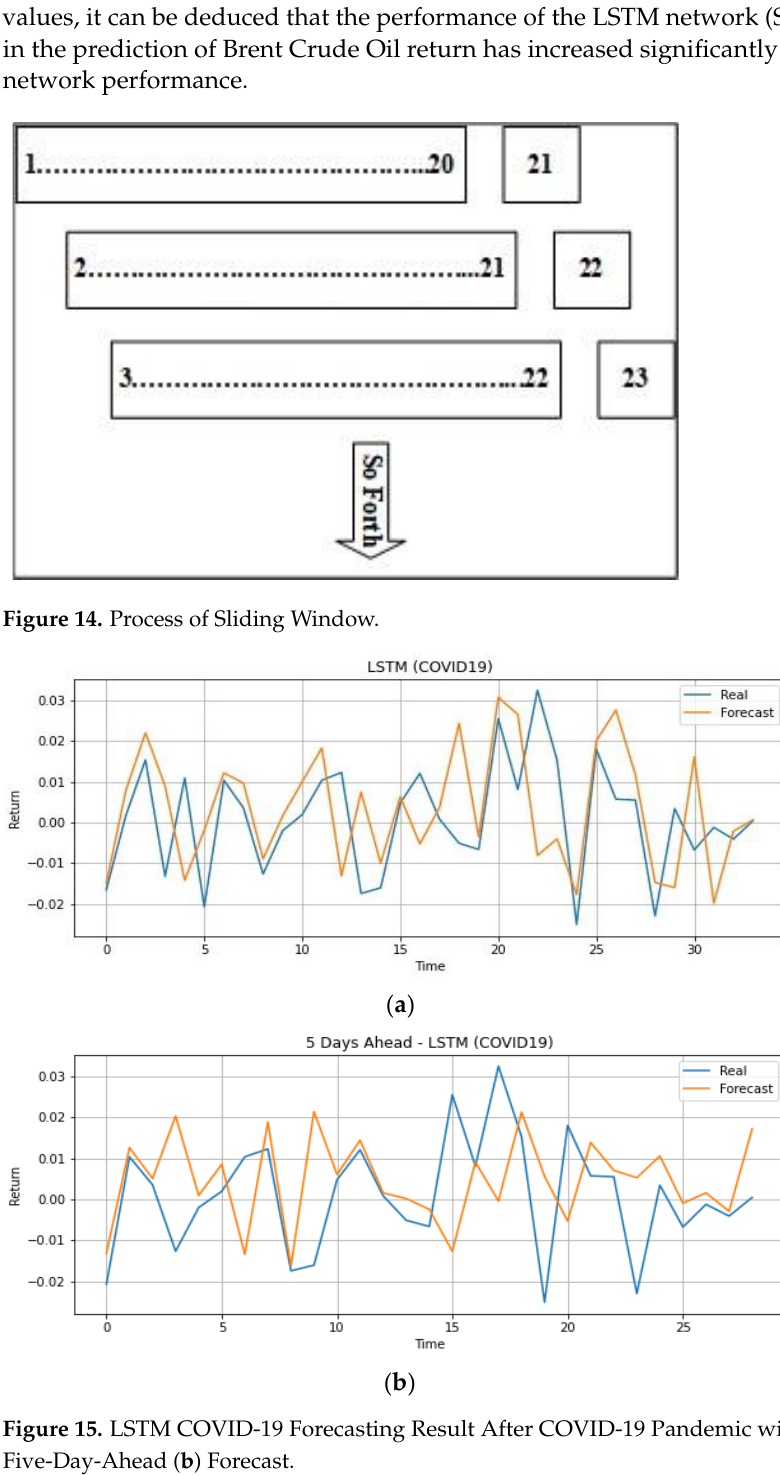
Table 16. The Value of Each Measure for the COVID-19 Period with Five-Day-Ahead Forecast.